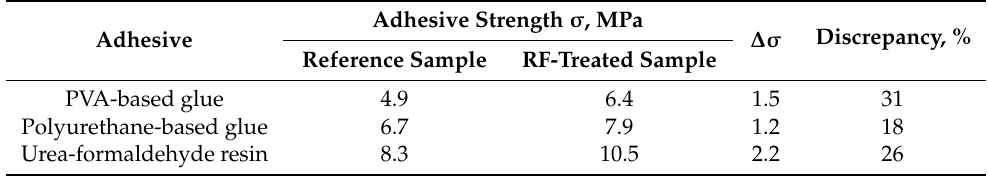
Table 2. Comparative analysis of the adhesive strength of wood.